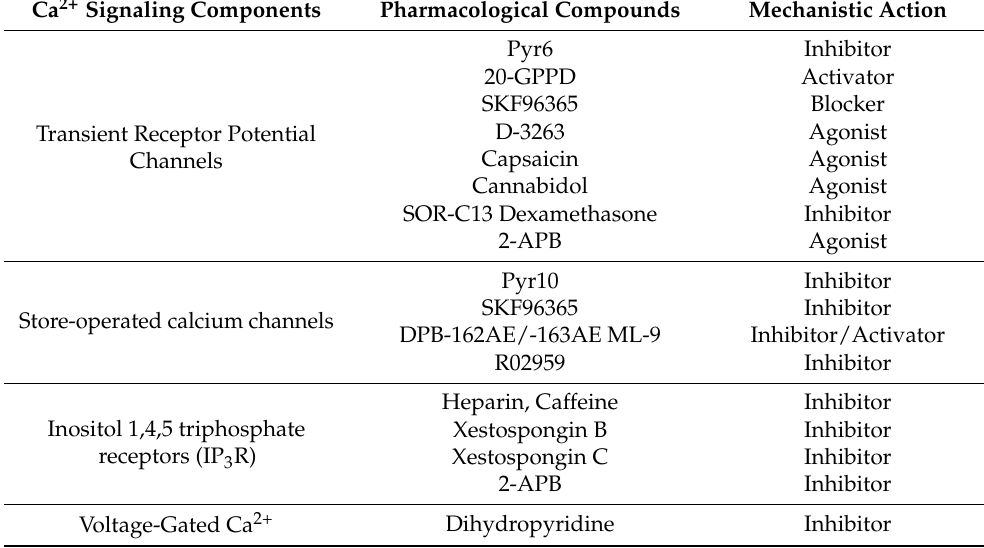
Table 1. Compounds targeting Ca 2+ signaling